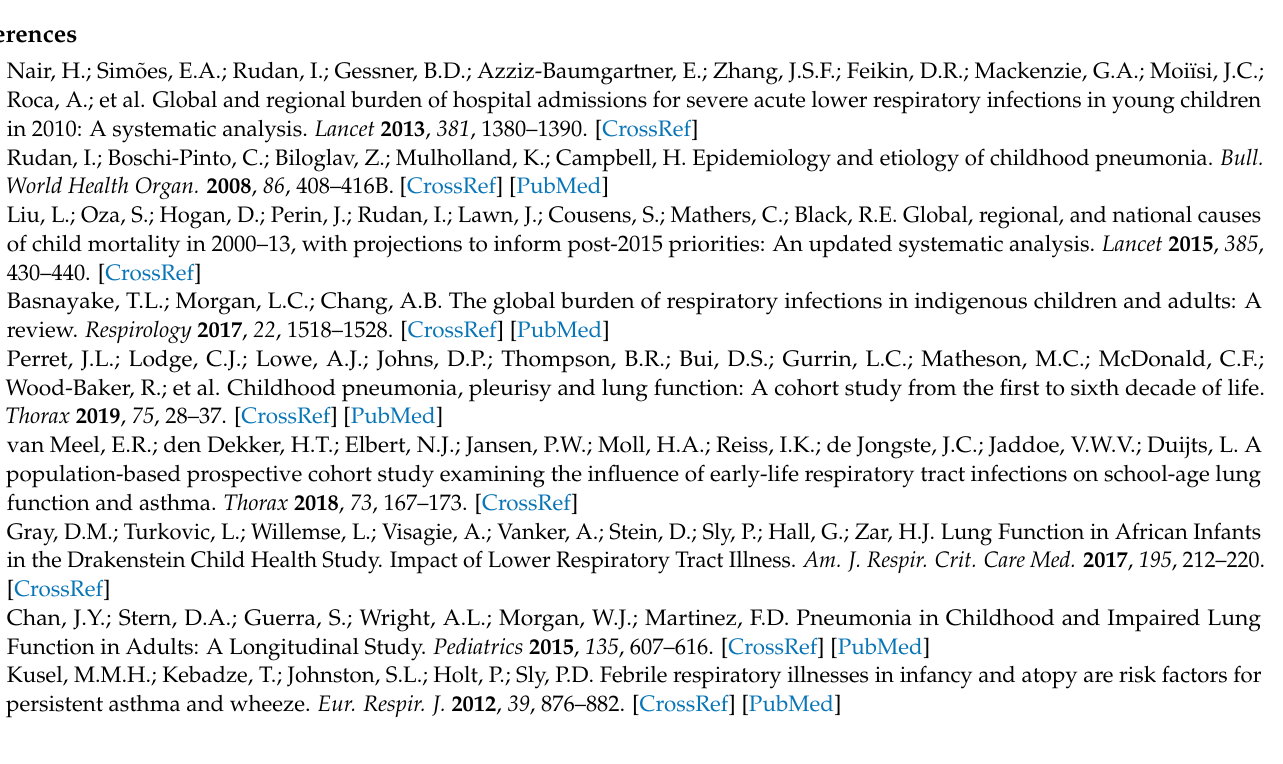
Figure S4: Scatter plots with lowess smoothing comparing FEV 1 /FVC% Z-scores of First Nations subjects whose pneumonia occurred age ≤ 5 years versus other